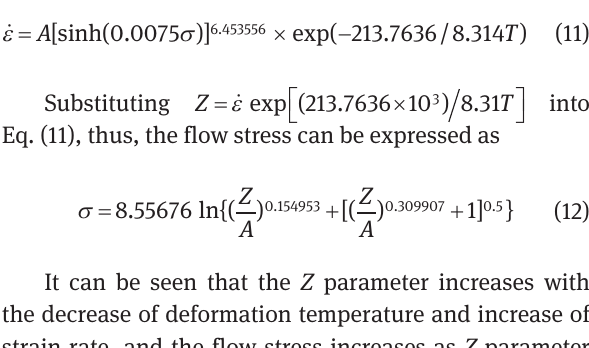
ln ) n Q RT A − value. Then ln ) n Q RT A − . The